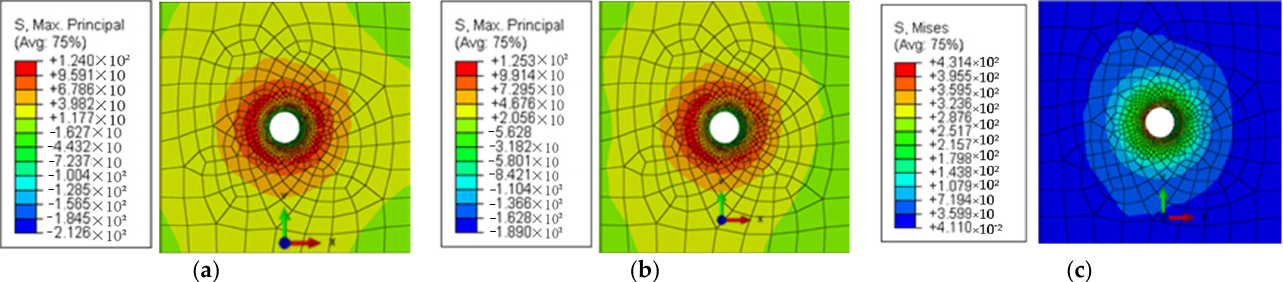
Figure 19. Distribution diagram of maximum principal stress of riveted joints of different riveting angles (unit: MPa): ( a ) distribution of maximum principal stress of 0° standard part (0-0); ( b ) distribution of maximum principal stress of riveted parts of 1° in the 0° direction (0-1); ( c ) distribution of maximum principal stress of 2° in the 0° direction (0-2).